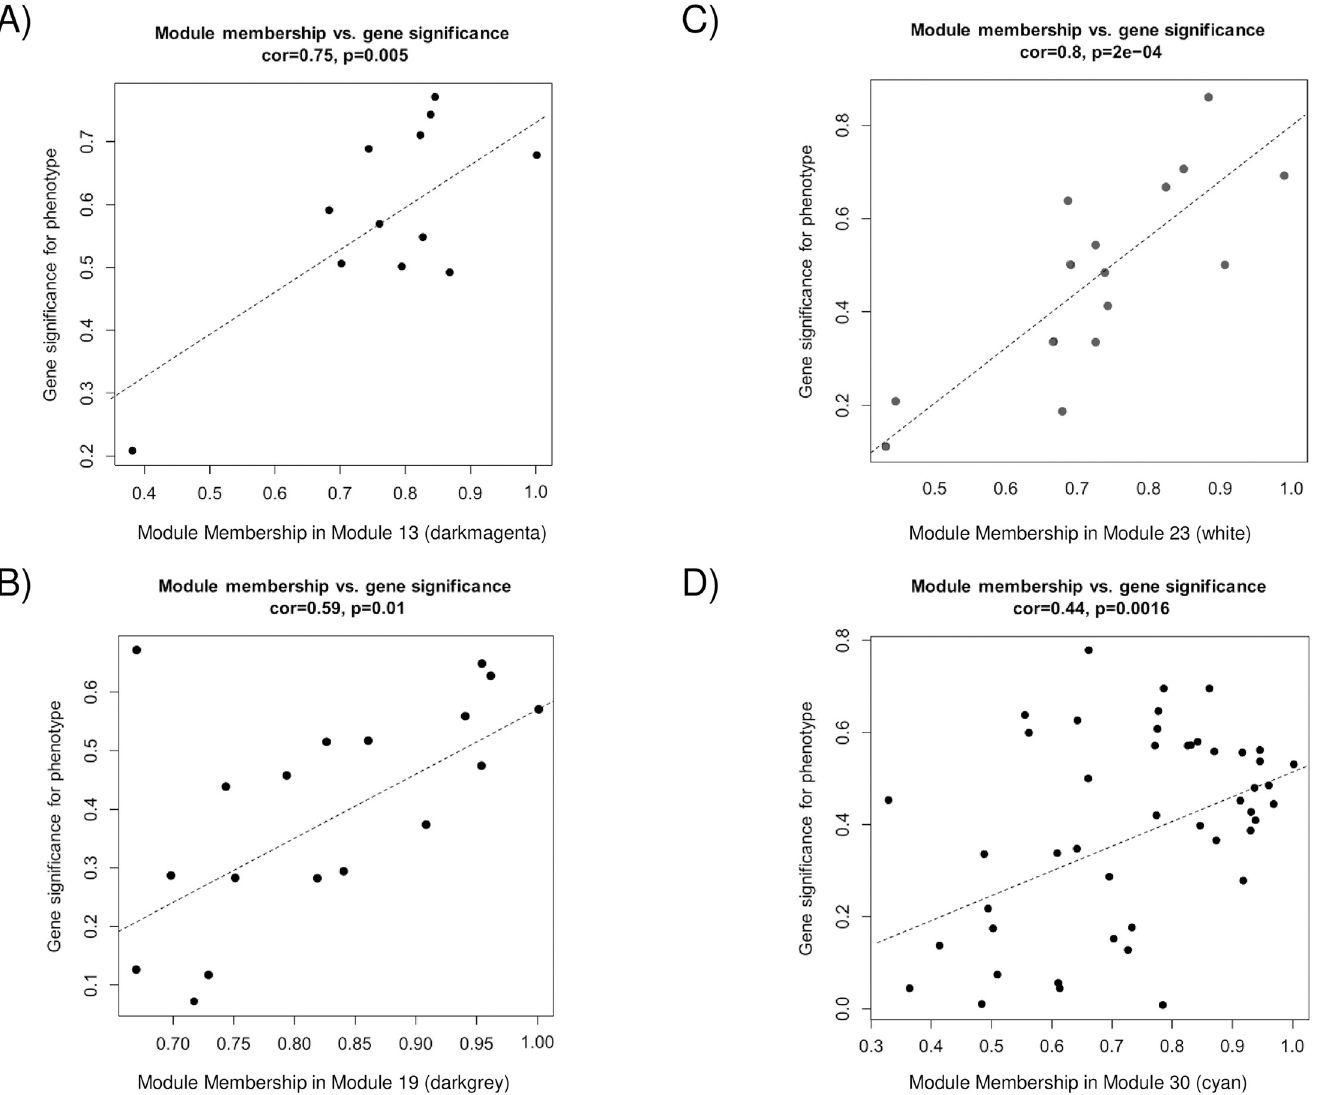
Fig 4. Relationship between gene significance and module membership. Gene significances are plotted against module memberships for the modules of A) 13 (darkmagenta), B) 19 (darkgray), C) 23 (white), and D) 30 (cyan).